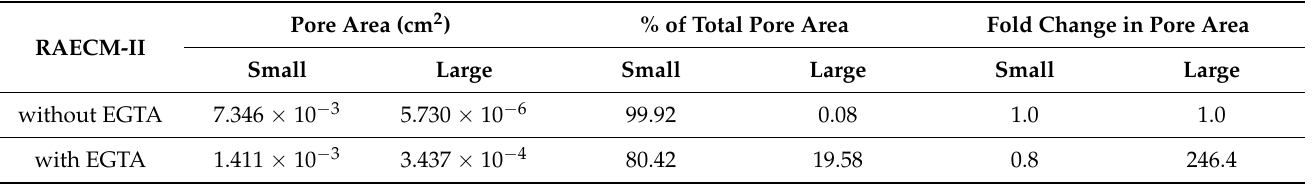
Table A6. B. Equivalent pore characteristics in response to EGTA treatment. Entries are based on the estimated values listed in Table A5. Equivalent pore area is per nominal surface area (1 cm 2 ) of RAECM-II.